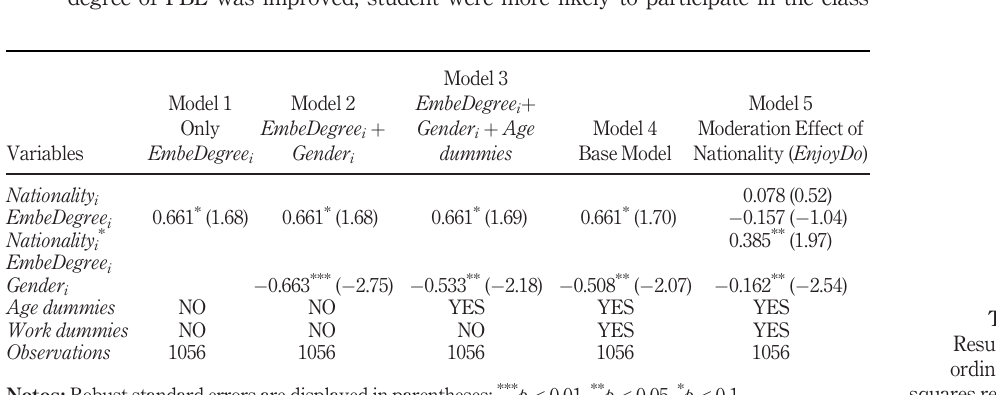
Table 6. Results of the ordinary least squares